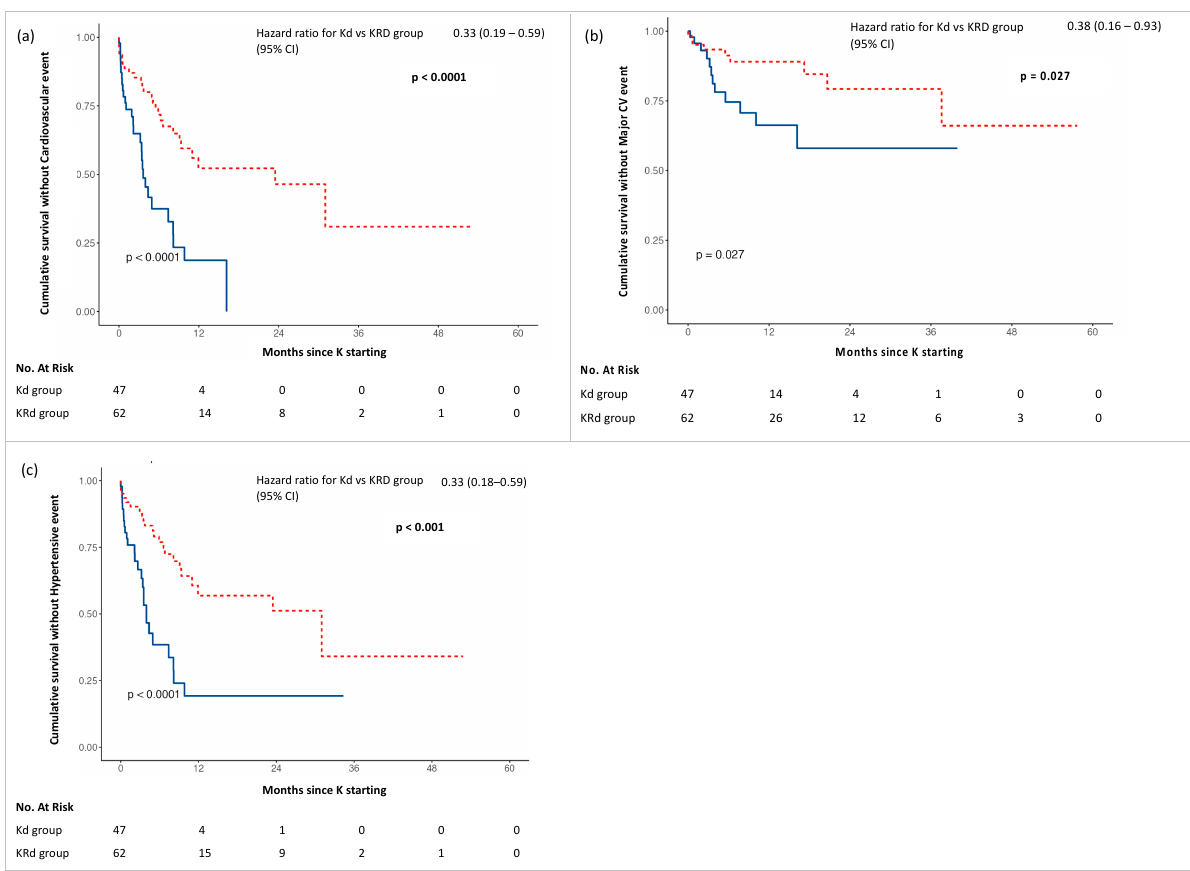
Figure 2. Kaplan–Meier curves for adverse events in Kd (blue) and KRd (red) groups: ( a ) Cumu- lative survival without Cardiovascular event; ( b ) Cumulative survival without Major CV event; ( c ) Cumulative survival without Hypertensive